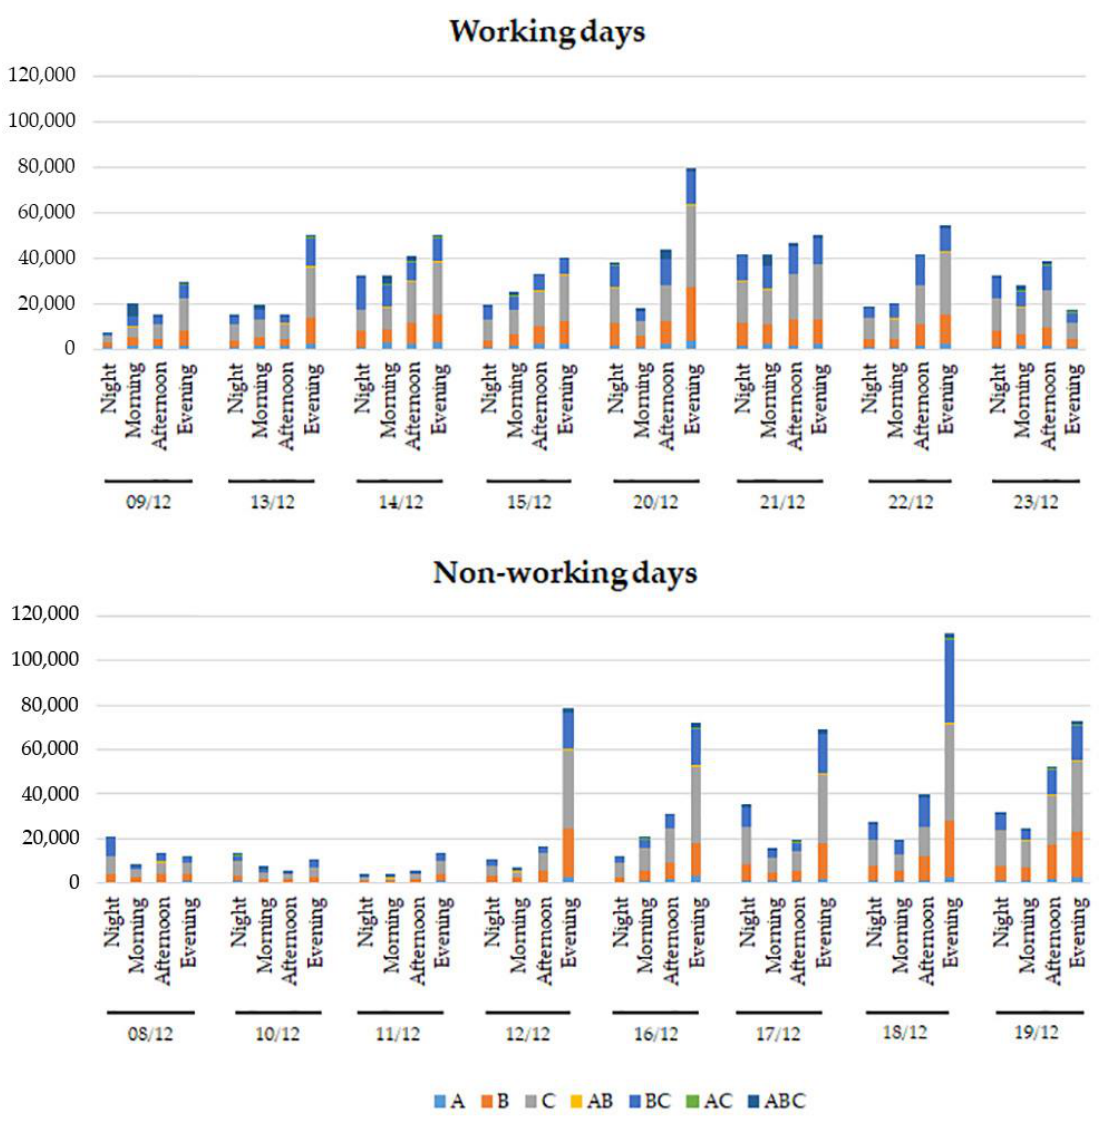
Figure 5. Daily number of fluorescent particles (y-axis), divided into four 6-h ranges (x-axis). Working days (WDs) and non-working days (NWDs) are shown separately.